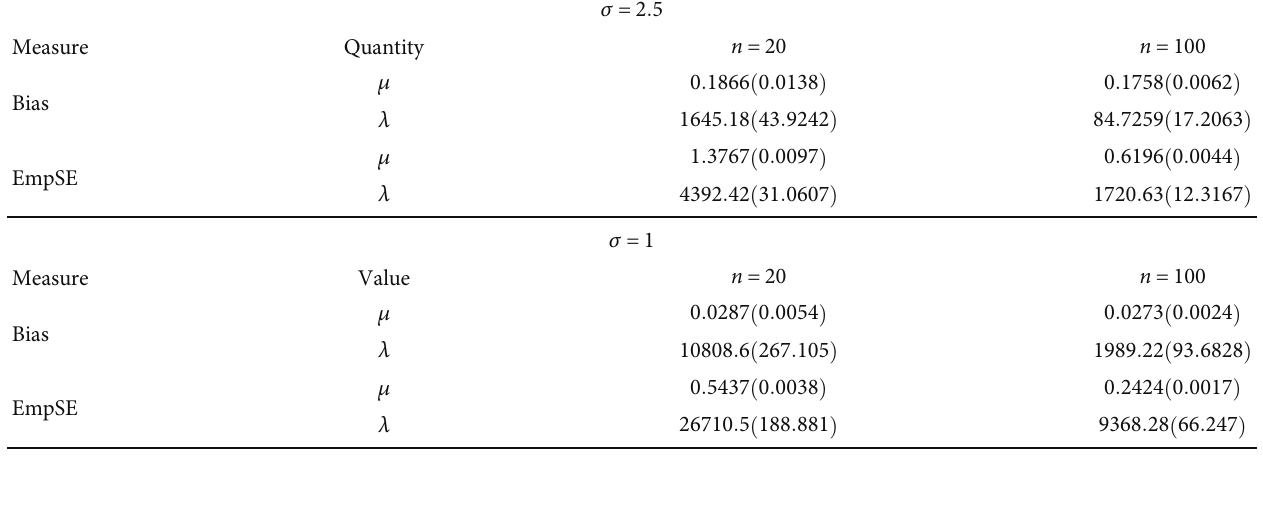
Table 4: Performance estimates for measures of interest based on the 10 4 replications and their Monte Carlo SE in parentheses.